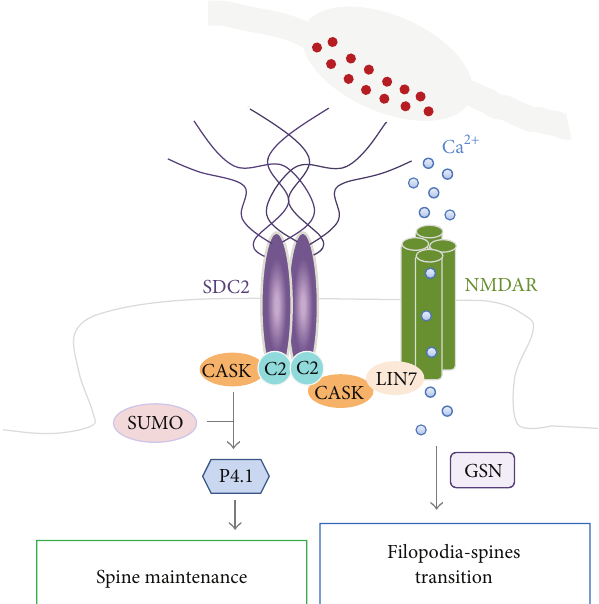
Figure 3: Syndecan-2 coordinates with calcium influx to control dendritic spine formation and maturation. Syndecan-2 links the CASK-mLIN7-NMDAR complex through its C2 motif and directs this complex to target to filopodial tips. It increases the accessibility of postsynapticfilopodia to presynapticstimulation, which iscritical for calcium influx to induce the filopodia-spines transition. In addition to linking mLIN7 and NMDAR, CASK interacts with the protein 4.1-F-actin cytoskeleton. This interaction provides a physical link between the membrane and cytoskeleton to stabilize the dendritic spine structure. GSN,